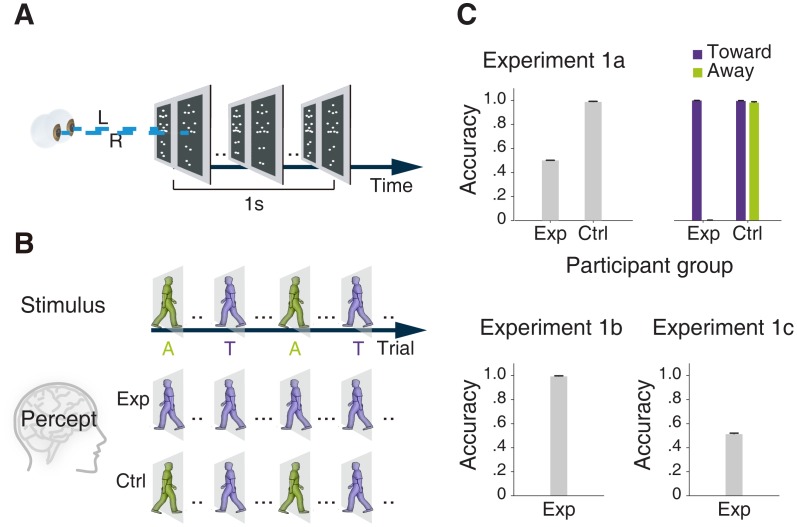
Schematic representations of 3D biological motion stimuli and results of Experiment 1.(A) During each trial, a pair of point-light walker sequences with horizontal binocular disparity was presented to the left and right eyes of the observer through a mirror stereoscope. (B) A series of point-light walkers, either facing toward (T-trial) or away (A-trial) from the observer defined by stereoscopic cues were displayed in random order. Observers were divided into experimental and control groups according to their perceived depth information. (C) The upper panel shows the contrast of accuracy for in-depth facing orientation judgment between the two groups, with the physical in-depth facing orientations combined or separated. Observers in the experimental group correctly identified the in-depth rotating direction of point-light sphere (lower left panel), yet their performance for discriminating the depth-reversed point-light walkers was at chance level (lower right panel). Error bars indicate one SEM.